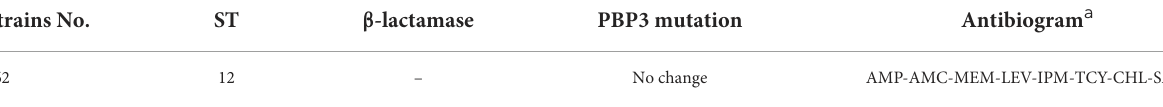
TABLE 2 Multi-resistant H. influenzae isolate feature. Strains No. ST β -lactamase PBP3